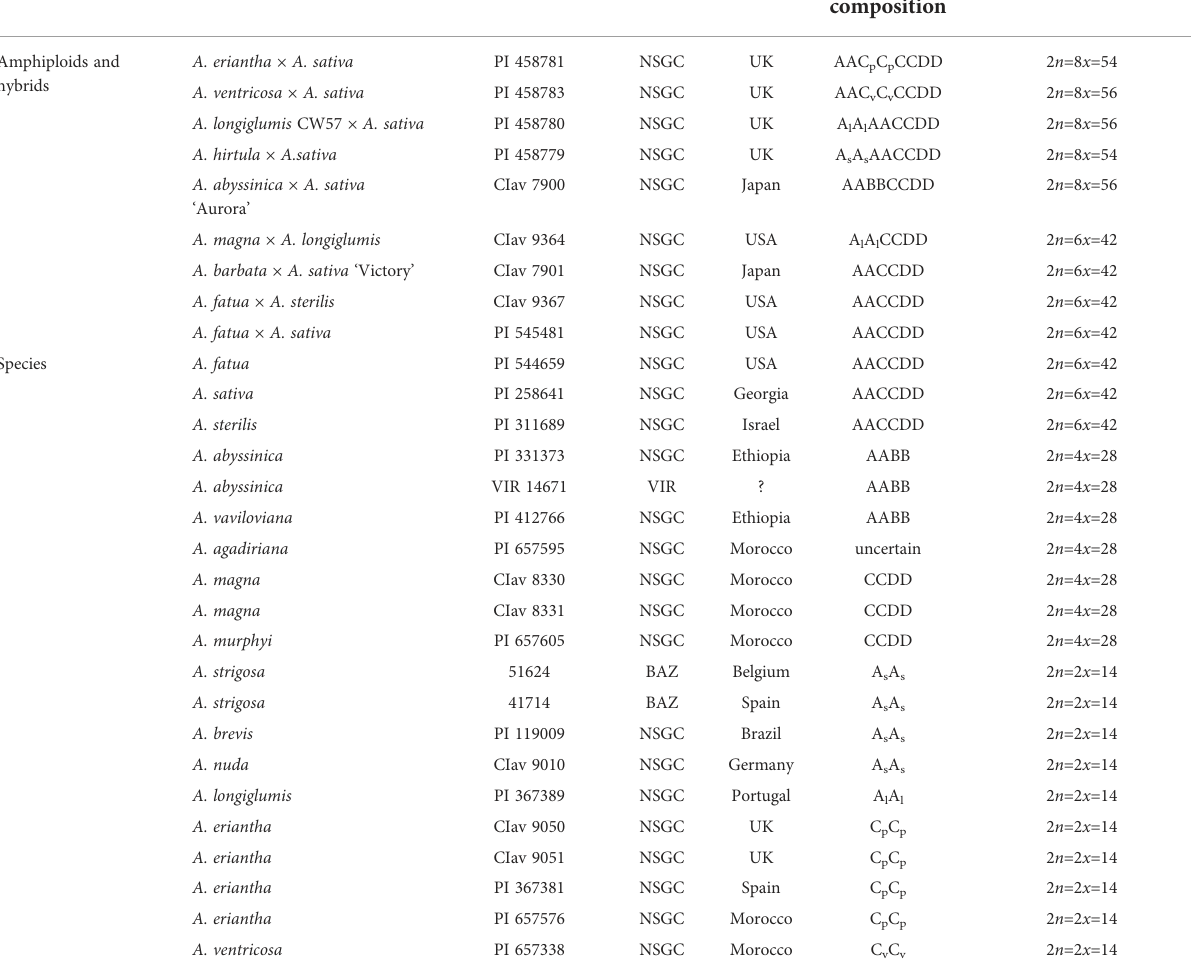
TABLE 1 List of species, hybrids and amphiploids of oats used in the